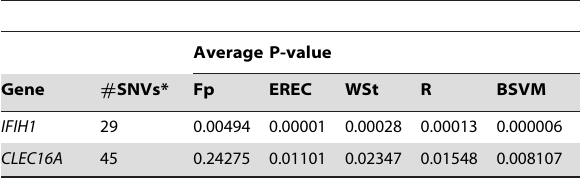
Table 4. Significance of the T1DM genes from the five methods.